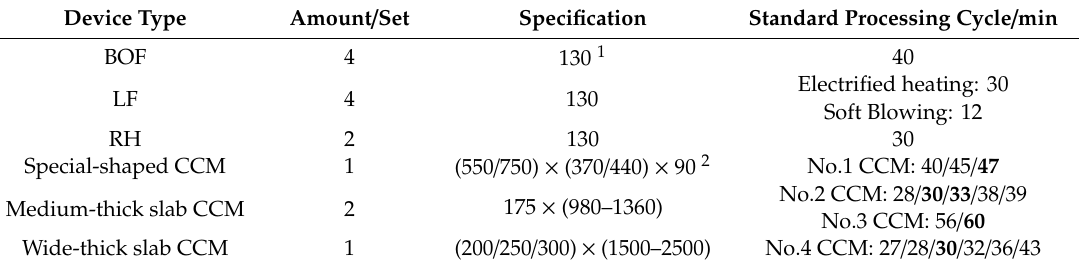
Figure 7. Workshop layout of SMCC in the studied steel plant. Table 2. Process configuration of SMCC in the studied steel plant.